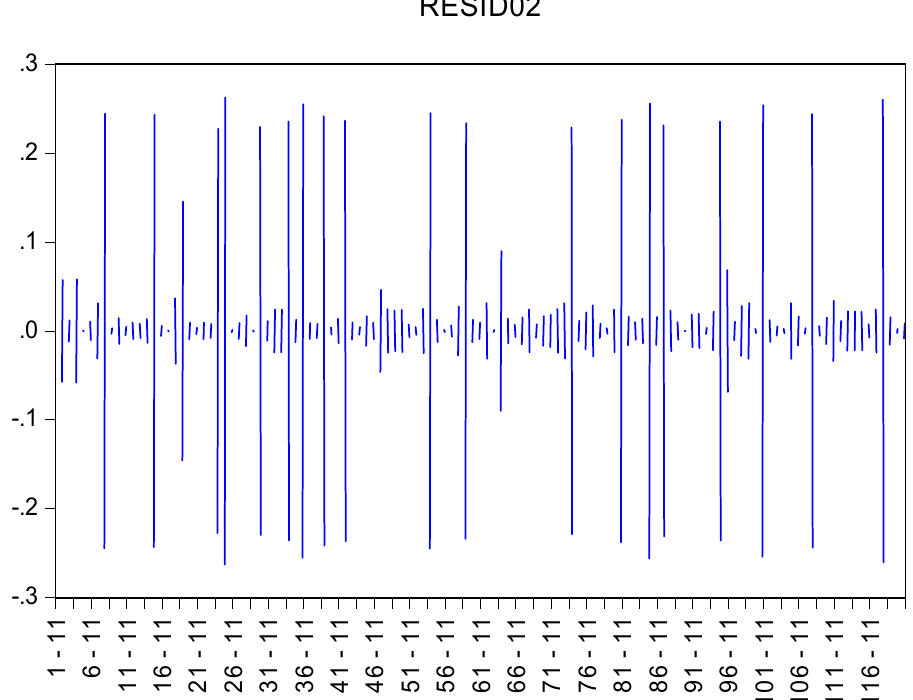
Figure 2. The influence of voter ownership concentration on the quality of board composition after the COVID-19 pandemic. Source: Author’s computations.